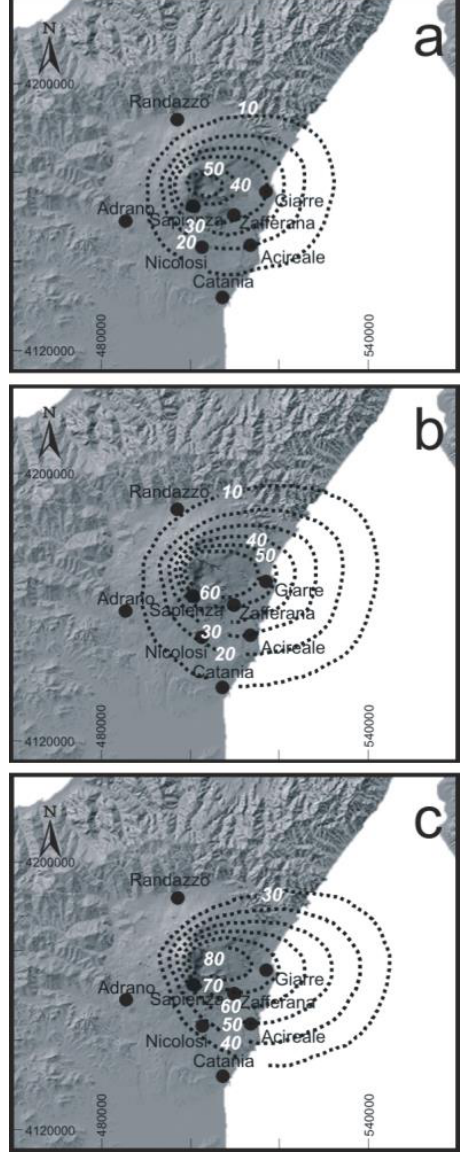
Fig. 10. Probability maps for the OES-SSL2, having similar fea- Figure 10. Probability maps for the OES-SSL2 having similar features to the 122 BC Plinian 674 tures to the 122BC Plinian eruption, considering thresholds of (a) 300kgm − 2 , (b) 200kgm − 2 , and (c) 100kgm − 2 . eruption considering thresholds of a) 300 kg m -2 , b) 200 kg m -2 , c) 100 kg m -2 . 675 The OES-WLL probability maps were compiled consider- ing an eruption lasting 100 days and producing a weak plume of 7 km a.s.l. Tephra accumulation has a very high probabil- ity (between 80–100 %) of exceeding 200 and 100 kg m − 2 within 12 and 18 km of the vent respectively, and mainly af- fected the southeastern flanks of the volcano (Fig.